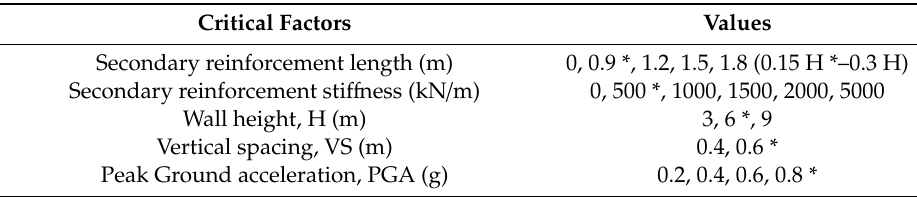
Table 4. Critical factors used in parametric studies.